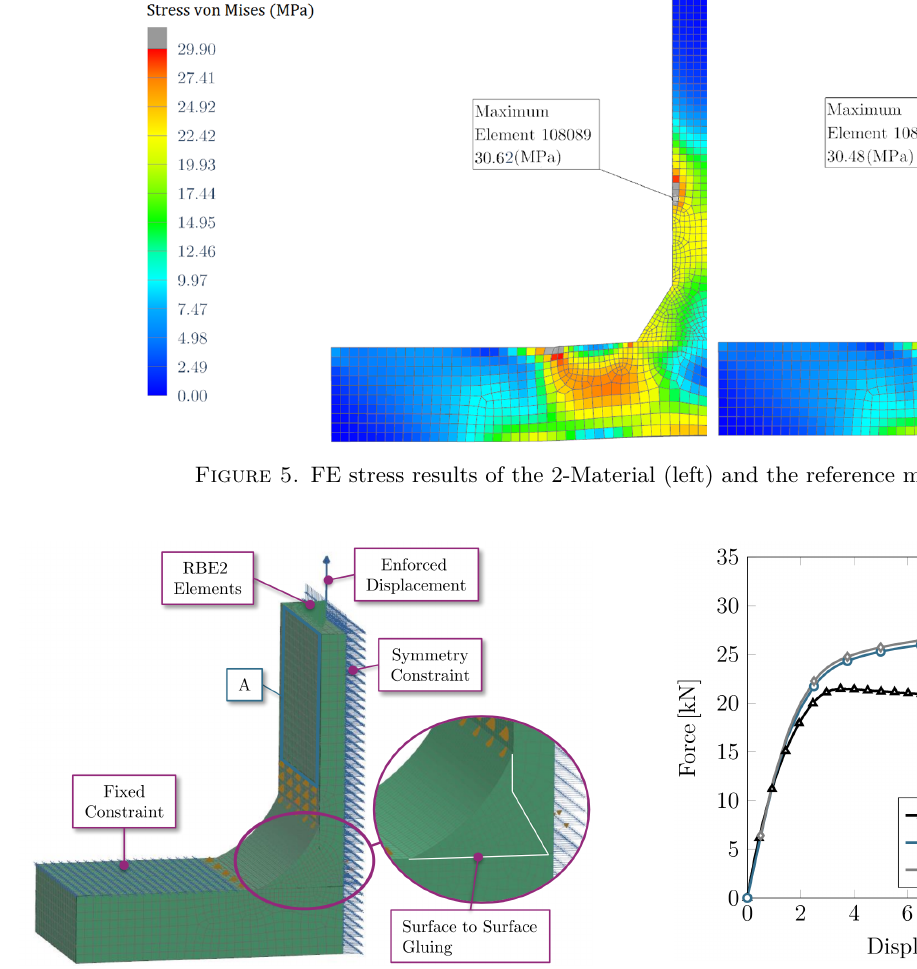
Figure 6. FE model of the T-joint. Figure 7. Experimental and FE analysis